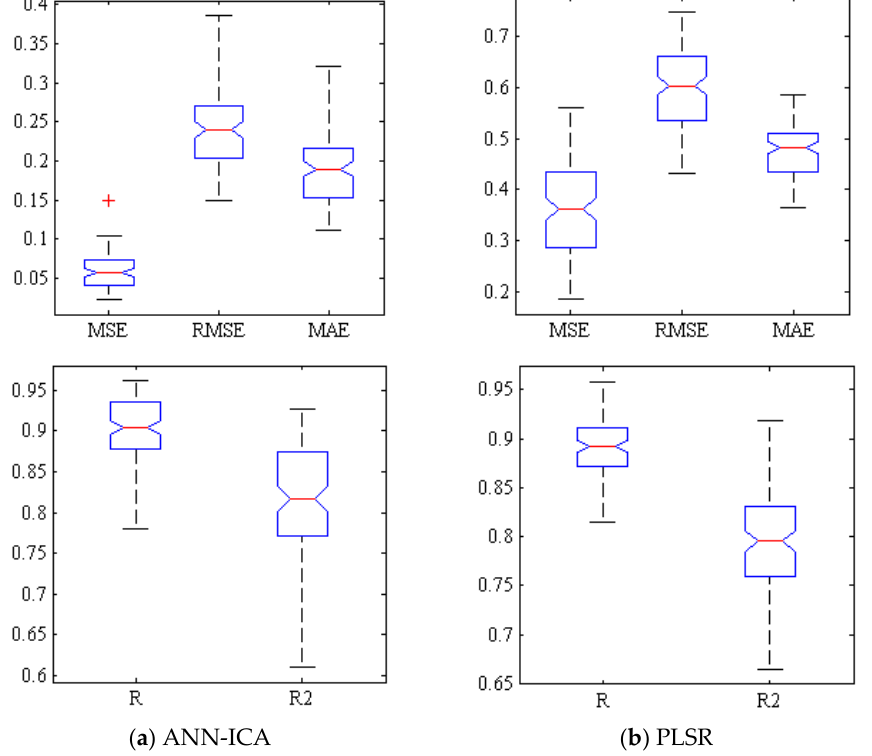
Figure 3. Box diagram of error criteria (1st row) and coefficients of correlation and determination (2nd row) related to ( a ) ANN-ICA and ( b ) PLSR in prediction of TSS.